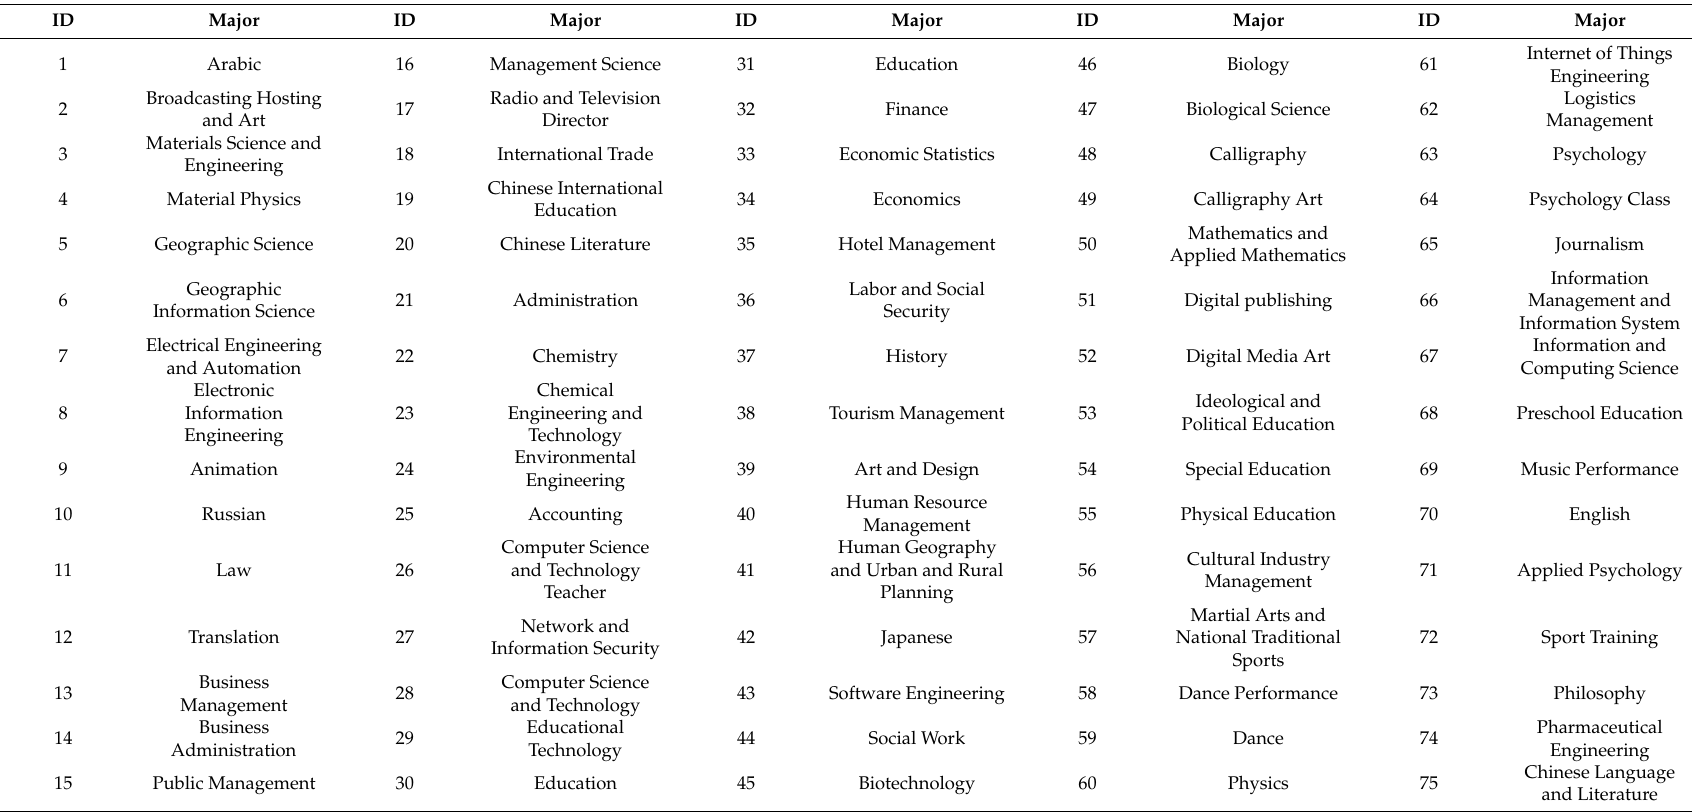
Table 7. Table of serial numbers of each discipline in the thermodynamic